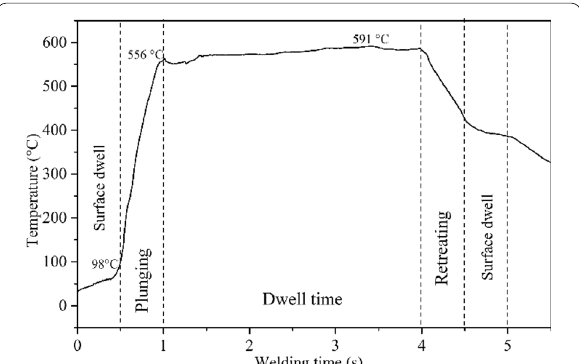
Figure 7 Thermal cycle measured at the weld interface center